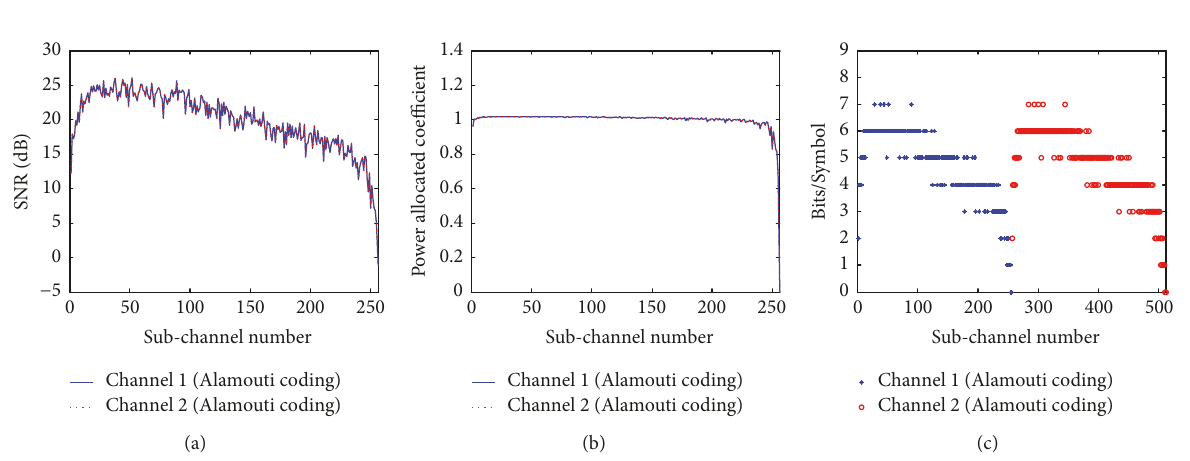
Figure 4: Power and bit allocation results for V-BLAST system ( K =5.4985, 𝐵𝐸𝑅 T =0.003).